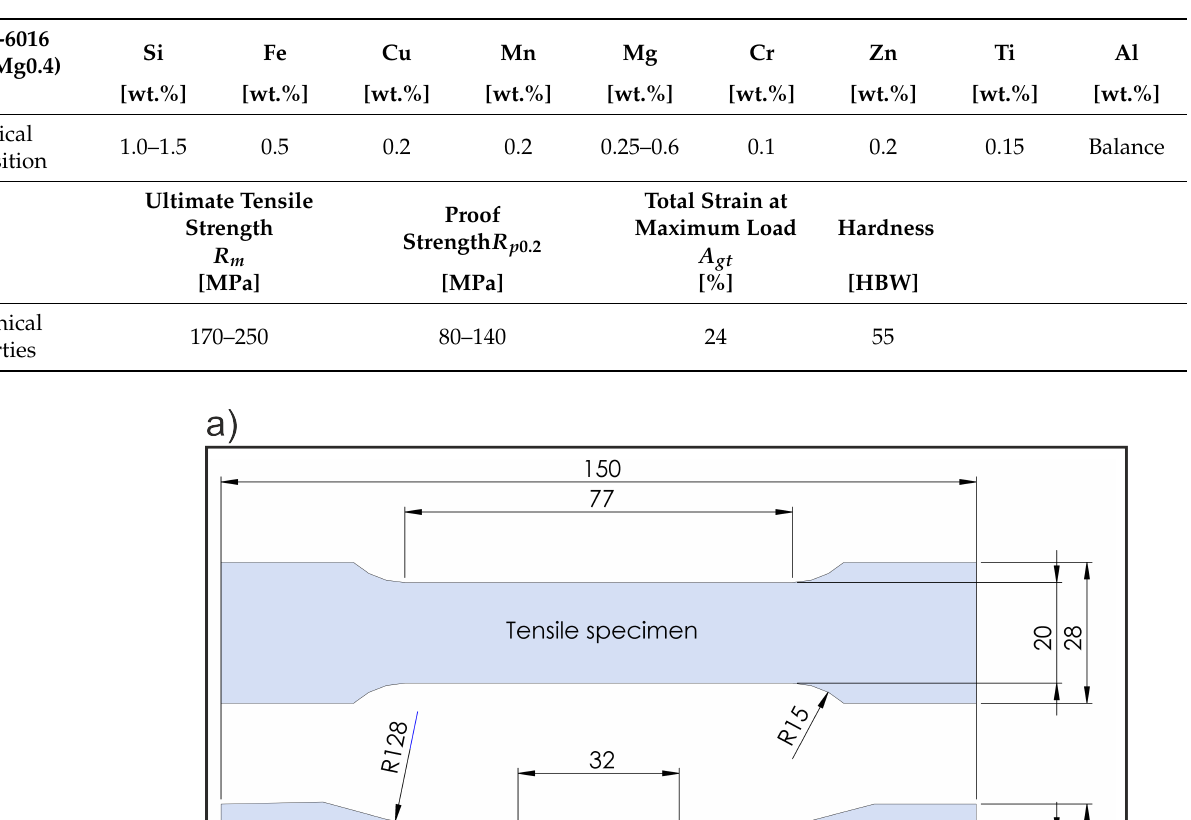
Table 1. Alloy composition of En AW-6016 T4 (AlSi1.2Mg0.4), according to DIN EN 573-3 and DIN EN 485-2 [26,27].